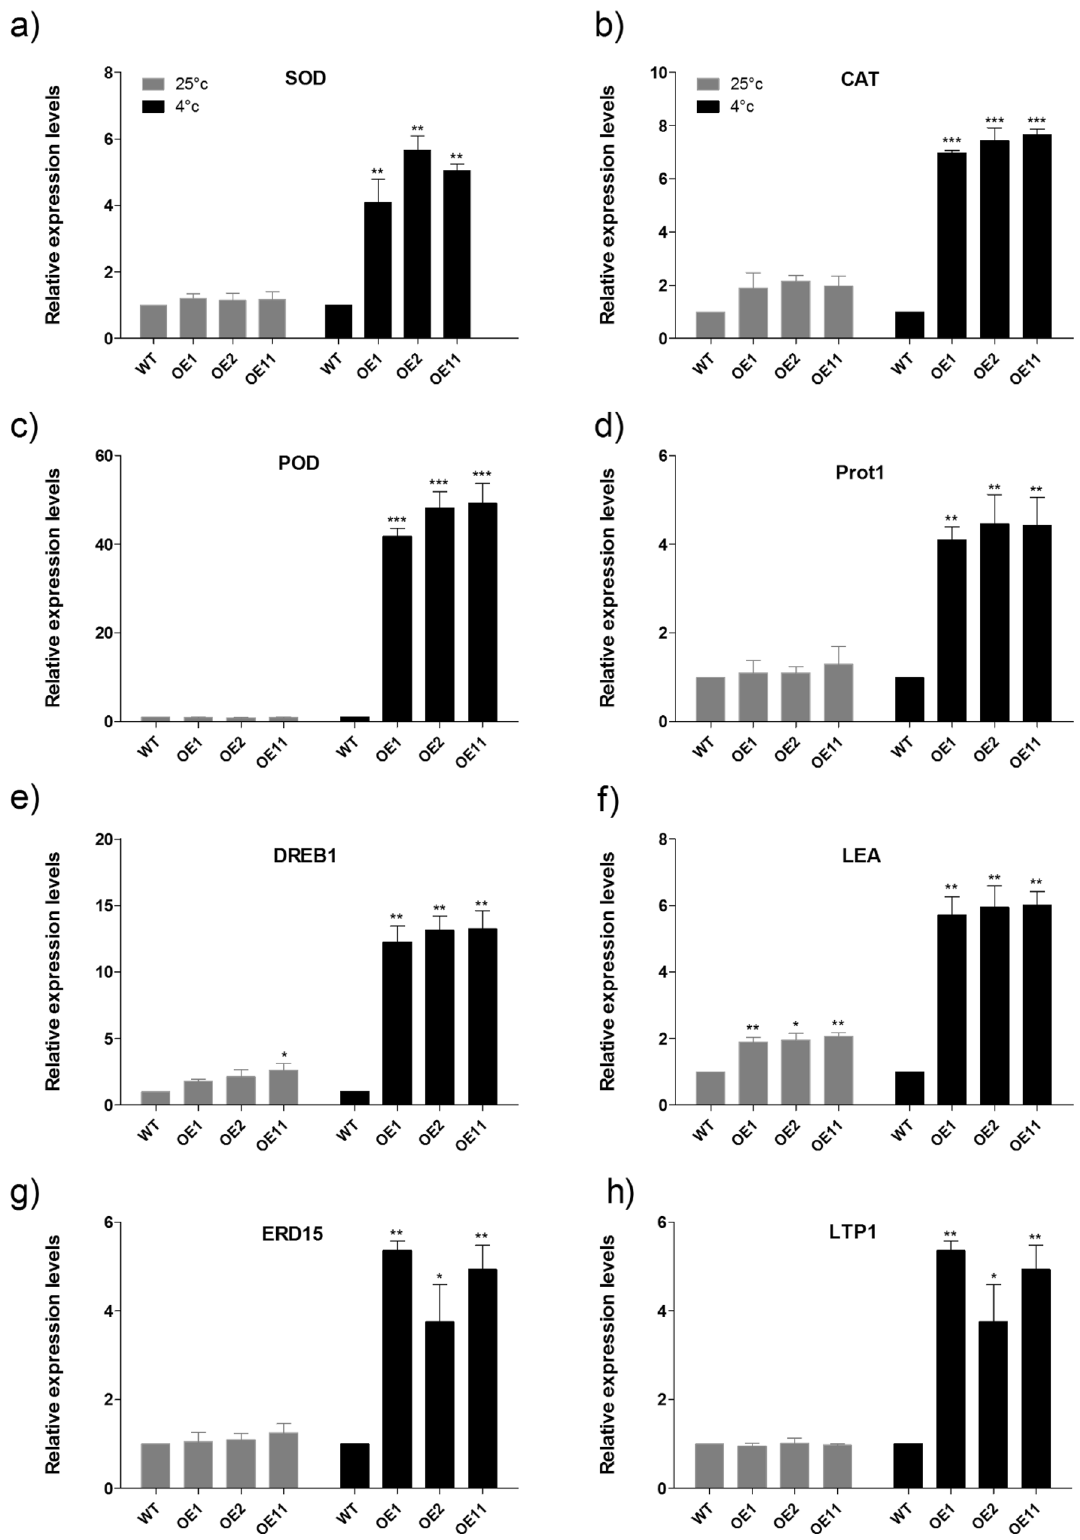
Figure 7. Expression levels of stress responsive genes in wild-type and Bo CRP1 transgenic lines. ( a–h ) depicts the transcript levels of SOD, POD, CAT, ProT1, DREB1, LTP1, ERD15-2 and LEA in wild-type and BoCRP1 overexpression lines. Six week old seedlings of transgenic lines and wild-type plants treated with cold (4 °C) or 25 °C (control) for 3 days were used to collect the samples for RNA extraction. For relative expression levels, 2 −∆∆CT method was employed using β-Tubulin as internal control to normalize the expression levels of target genes. Data represents the mean ± SD of three biological replicates. Each sample replicate composite of leaves was collected from a total of 12 seedlings. WT represents the wild-type tomato, OE1, OE2 and OE3 represent three independent putative BoCRP1 transgenic tomato lines. Asterisks represents the significant differences between wild-type and transgenic lines. * P < 0.05; ** P < 0.01, *** P < 0.001 Tukey’s Multiple Comparison